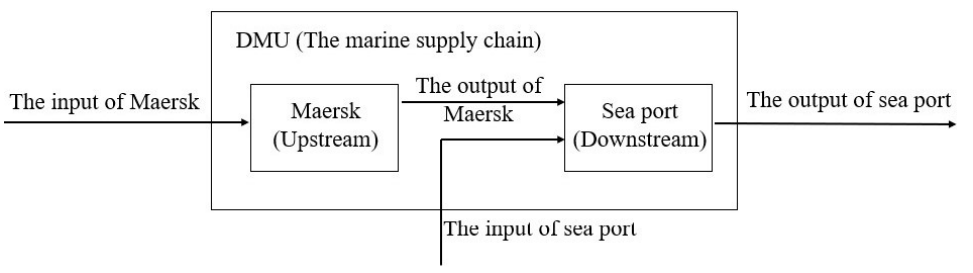
Figure 2. The structure of marine supply chain.